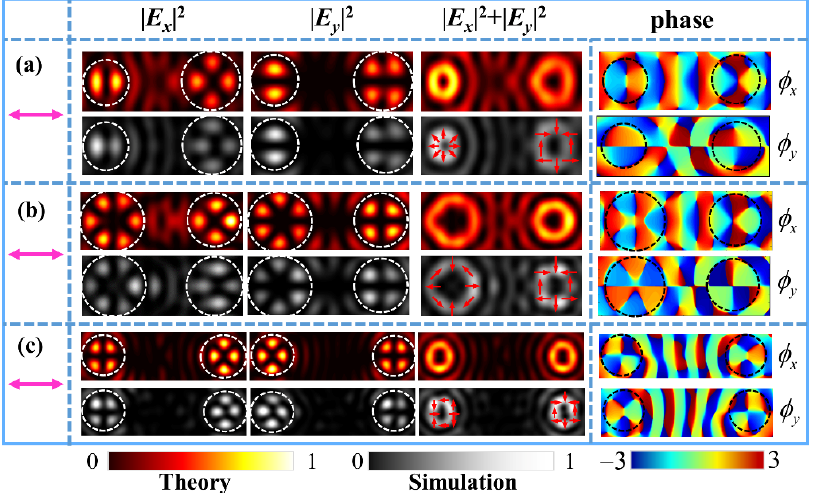
Figure 4. The intensity patterns of different FVBs of the theoretical results and FDTD simulations under horizontally polarized light illumination and the corresponding theoretical phase distributions of x - and y -components. ( a ) The radially polarized dual-channel FVBs of orders l l = 1 and l r = 2. ( b ) The radially polarized FVBs of orders l l = 3 and l r = 2. ( c ) The azimuthally polarized and radially FVBs of order 2 in the left and right channels.